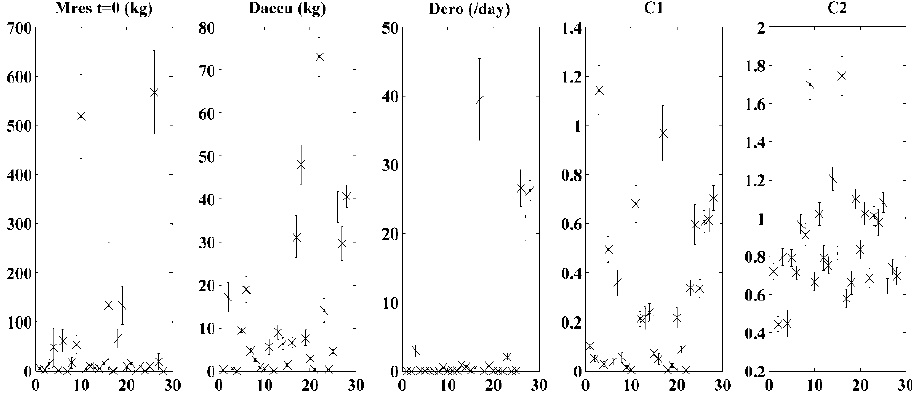
Figure 9. Standard deviation of the posterior probability of build ‐ up and wash ‐ off parameters.